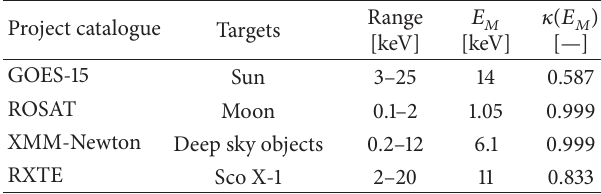
Table 3: Mean spectral energies 𝐸 𝑀 for selected space instruments and catalogues used in this article together with corresponding spectral sensitivity 𝜅(𝐸 𝑀 ) of TimePix detector.